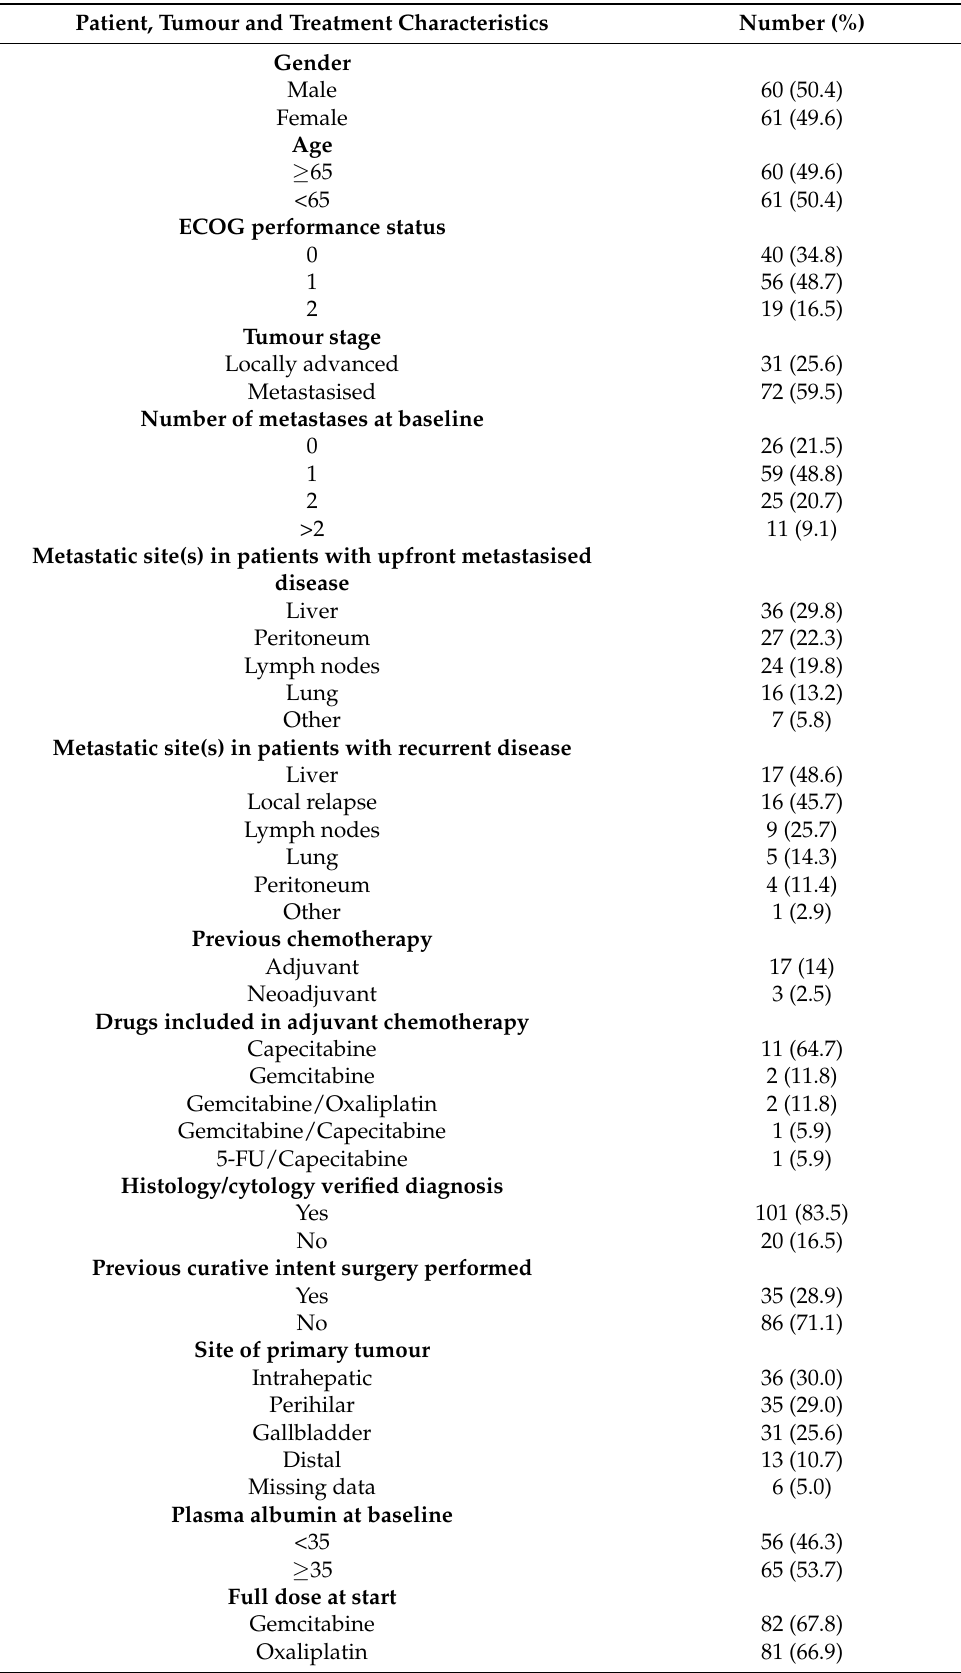
Table 1. Patient, tumour and treatment